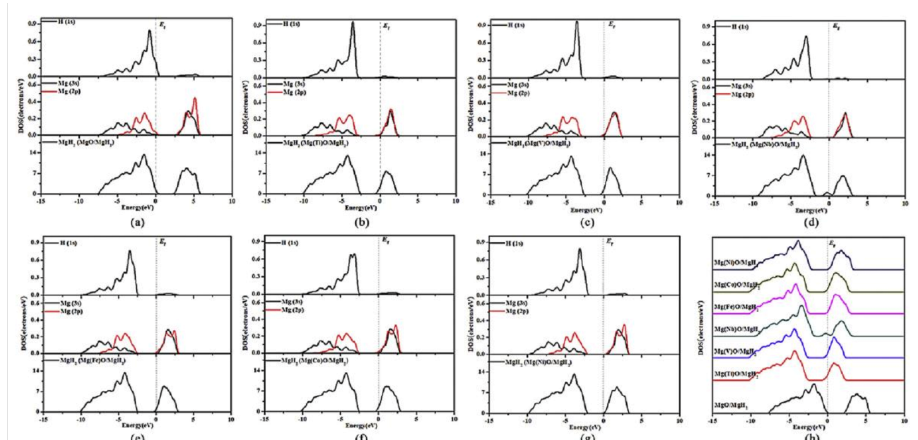
Figure 13. The calculated DOS of different interface models. ( a ) MgO – MgH 2 . ( b ) Mg(Ti)O – MgH 2 . ( c ) Mg(V)O – MgH 2 . ( d ) Mg(Nb)O – MgH 2 . ( e ) Mg(Fe)O – MgH 2 . ( f ) Mg(Co)O – MgH 2 . ( g ) Mg(Ni)O – MgH 2 . h) The comparison of DOS of MgH 2 matrix in different interface models. ( a – h ) Reproduced with permission [30]. Copyright 2018, Elsevier.